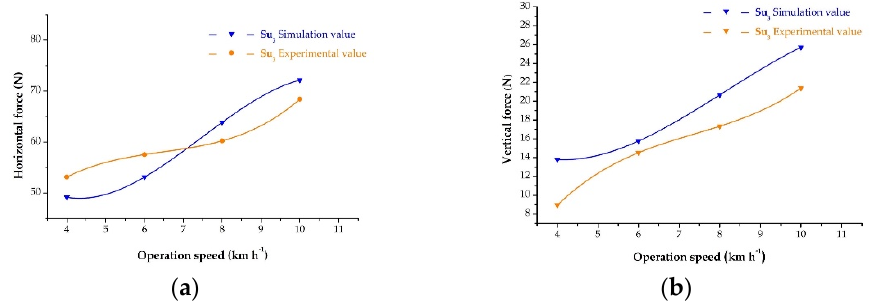
Figure 18. Comparison of the test results of Su 3 in the discrete element test and the indoor soil bin test under different operating speed conditions. ( a ) Horizontal force; ( b ) Vertical force.